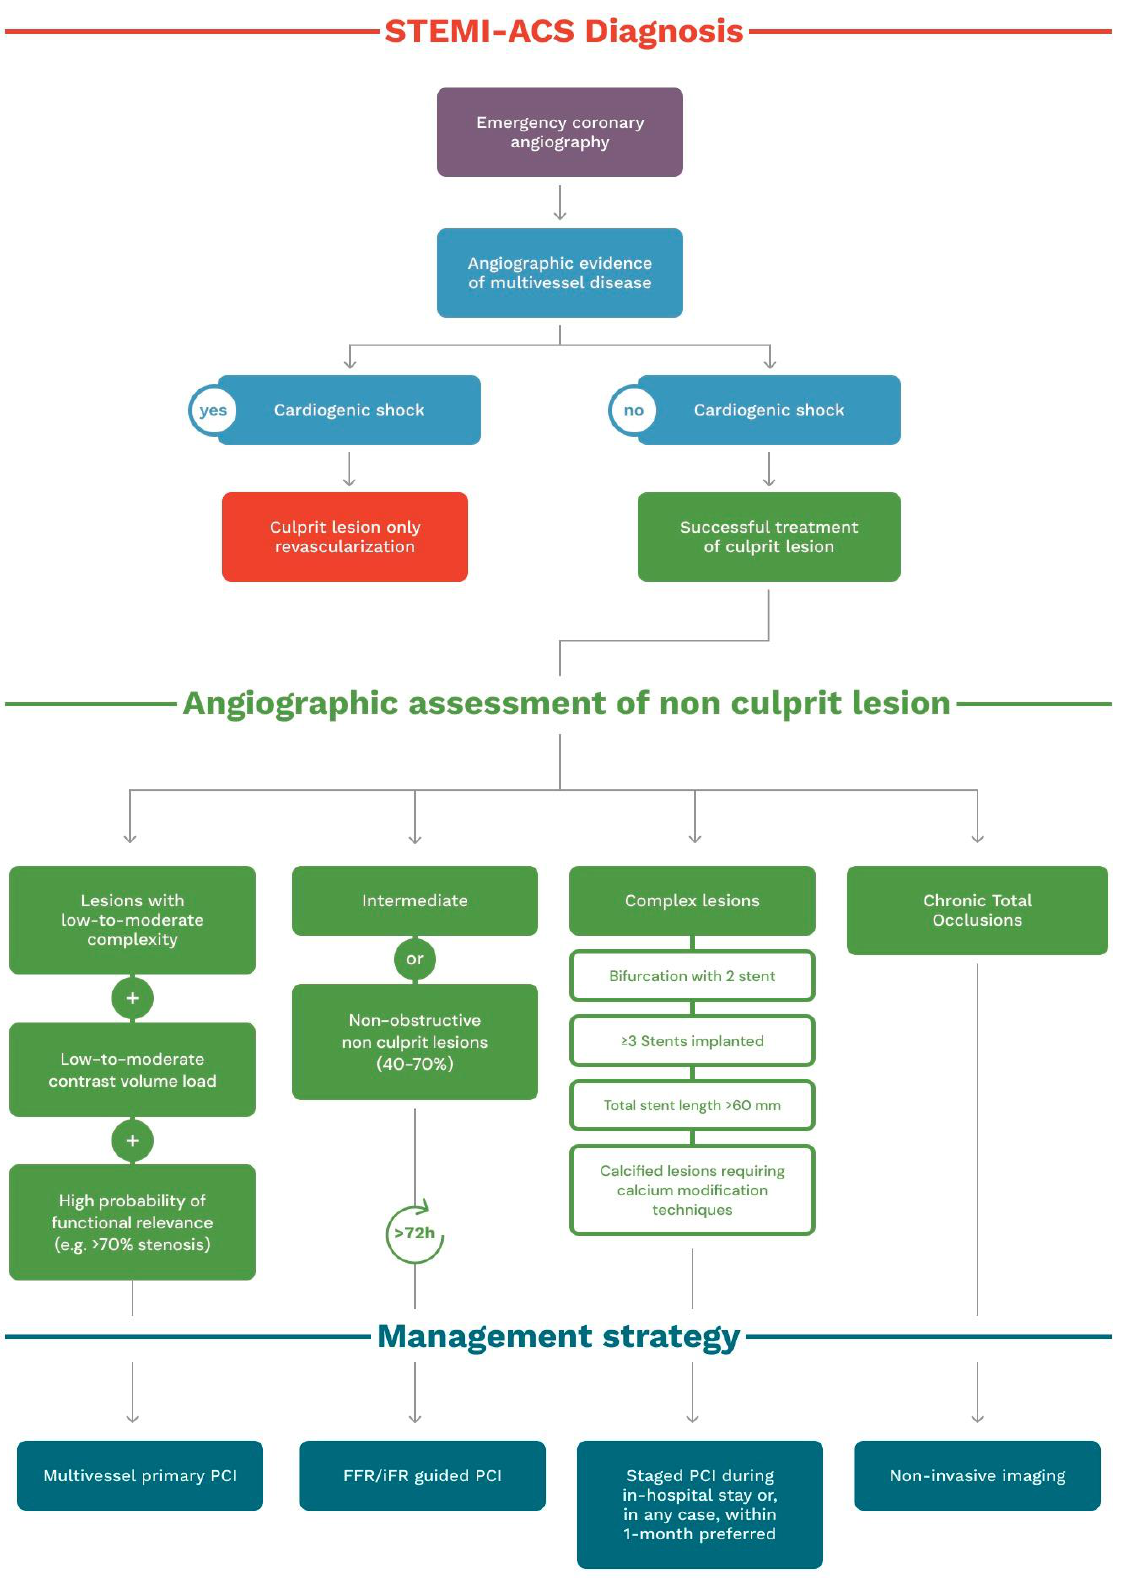
Figure 1. Treatment algorithm.